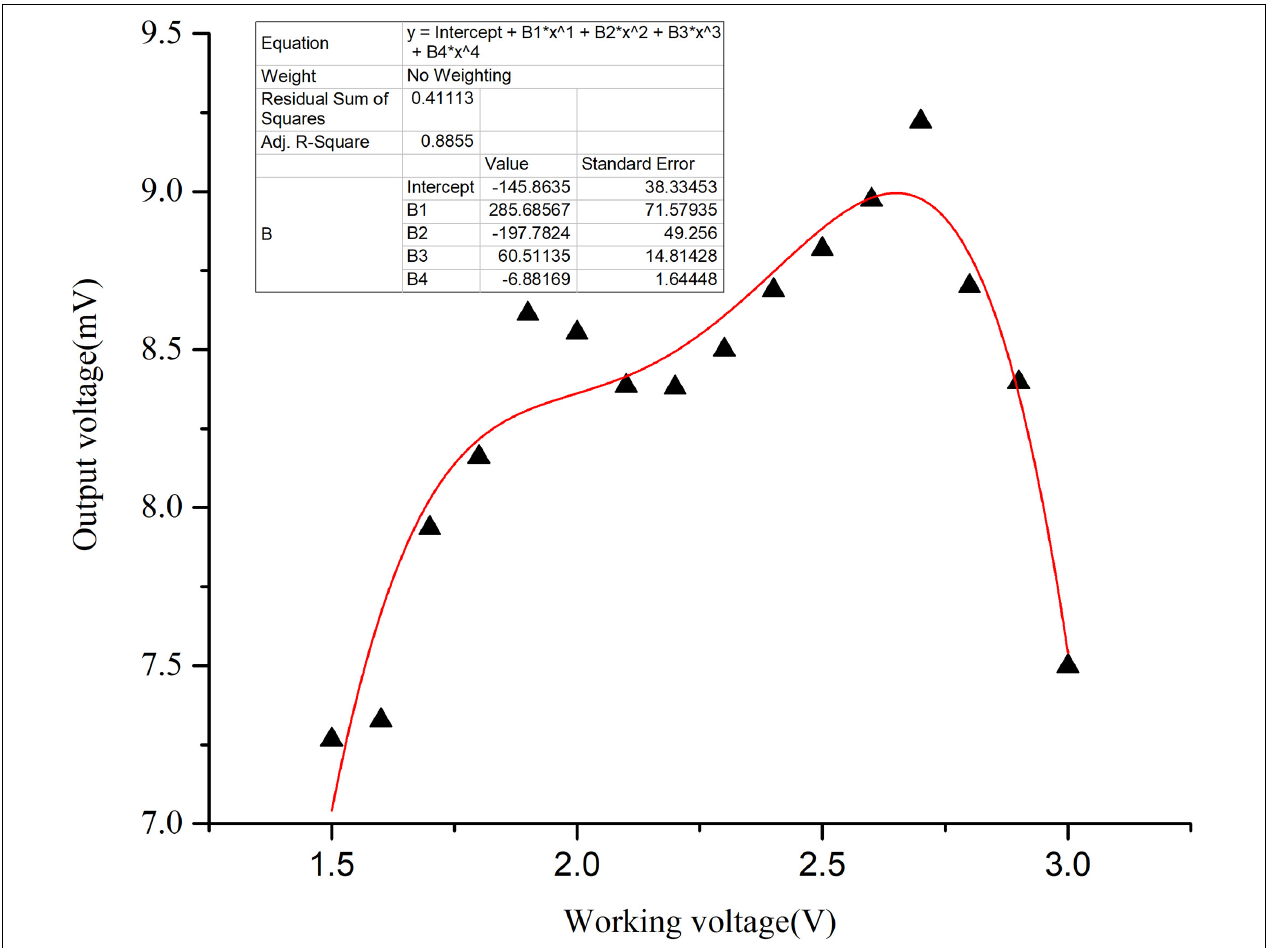
FIGURE 8 | Sensitivity fitting curve of 10% CO 2 under different working